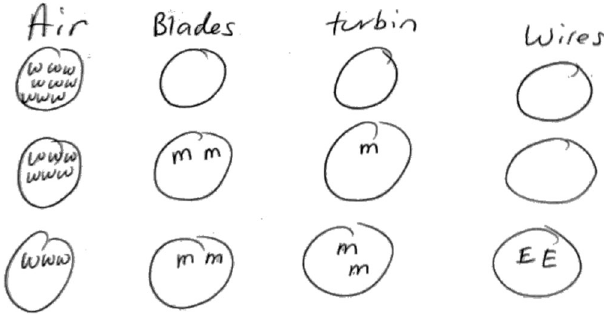
FIG. 8. A learner-invented “ energy snapshots ” diagram for a wind turbine scenario.